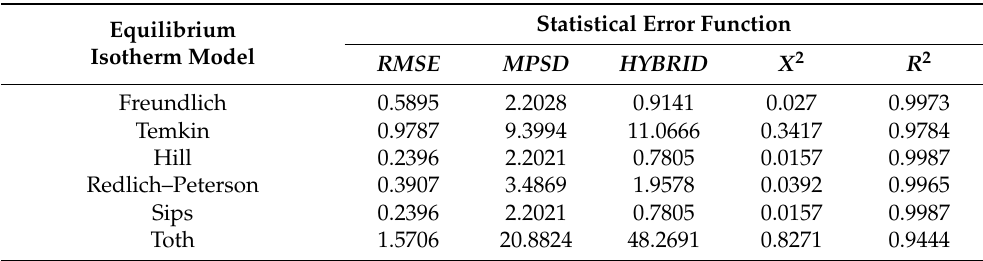
Table 10. Statistical error functions of estimated equilibrium isotherm nonlinear models for the biosorption process conducted on SPA 5% biosorbent.